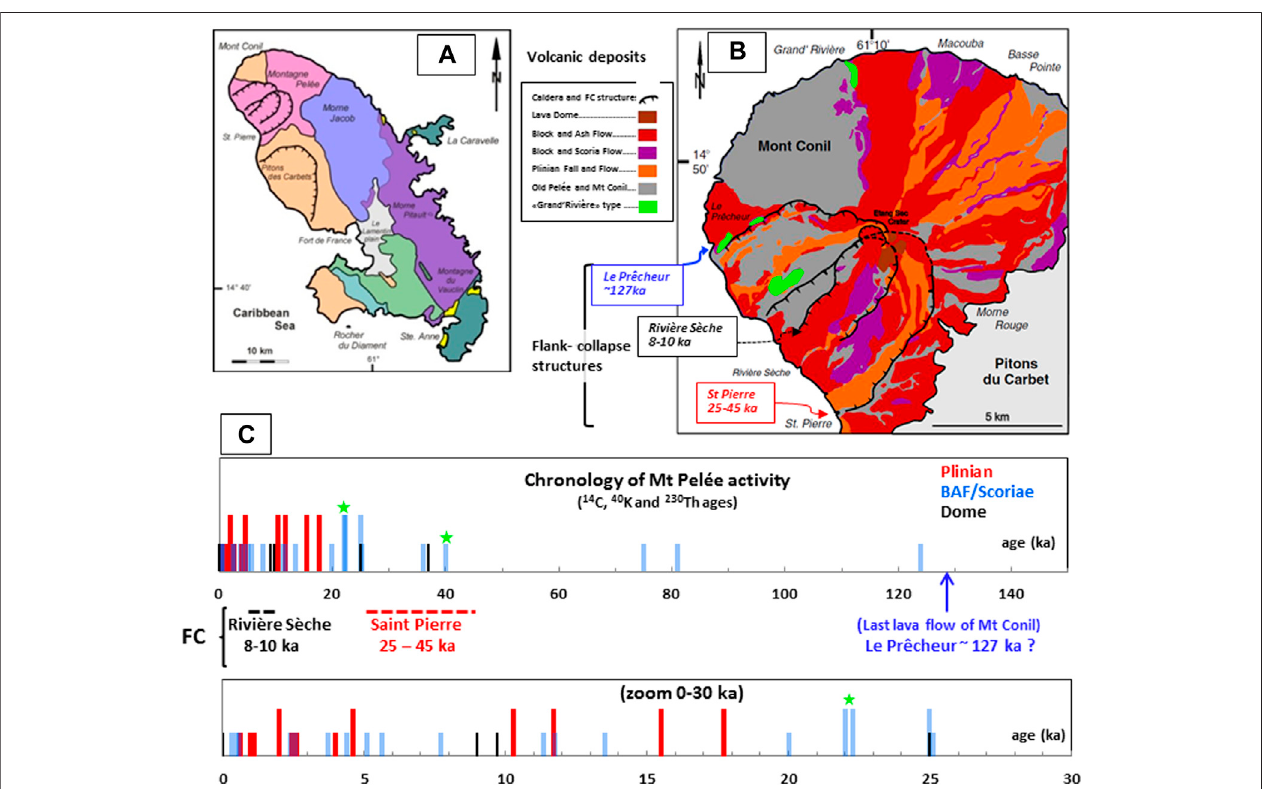
FIGURE2| ChronologyofthevolcanicactivityofMartinique. (A) VolcaniccentersofMartinique(fromGermaetal.(2011a)). (B) Volcanicdepositsand fl ankcollapse structuresof MtPelée (modi fi ed from Le Friant et al.,2003and Boudon et al., 2013). Flankcollapse structuresare dated by bracketing withages ofdomes grown inside the collapse scarps or cut at collapse structure edges: “ Le Prêcheur ” (K-Ar 3 ); “ Rivière sèche ” (U-Th 2,5 ); and “ St Pierre ” (K-Ar 3 ,U-Th 2,5 , 14 C 1 ). (C) Chronology of the volcanic activity and fl ank collapse structures of Mt Pelée. Eruptive styles: Dome: lava dome; BAF: block and ash fl ow; scoriae: scoria fall or fl ow; Plinian: plinian fall or fl ow; FC: fl ank collapses. The height of the bars relates to the relative intensities of the eruptions. Green stars: the two dated “ Grand Rivière ” events that produced ma fi c scoriae. Data sources: (1) Westercamp et al., 1989 ( 14 C); (2) Le Friant et al., 2002 ( 14 C-U/Th); (3) Germa et al., 2011a (K-Ar); (4) Michaud-Dubuy ( 14 C), 2019, (5) Villemant et al. (U/Th, unpublished); (6) Ishizuka et al., ( 14 C-K/Ar unpublished); see also Supplementary Table S3 .